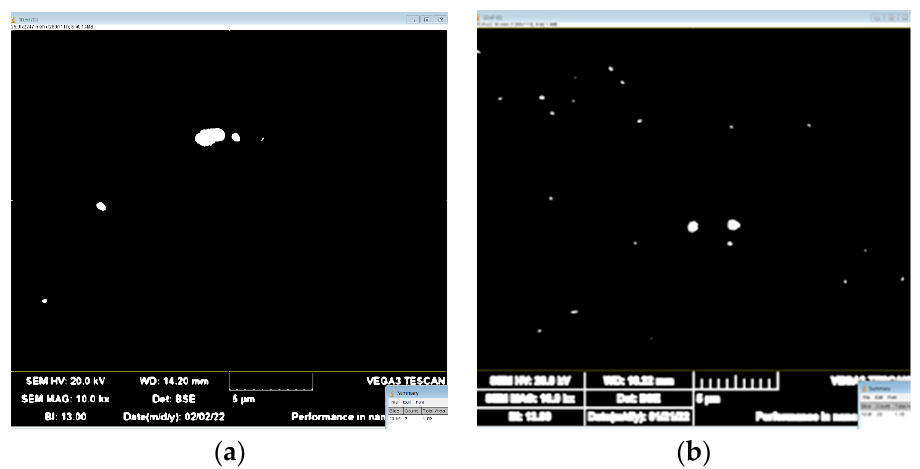
Figure 9. Scanning electronic microscopy of ( a ) 5Mg and ( b ) 5Mg0.5Mn alloys.